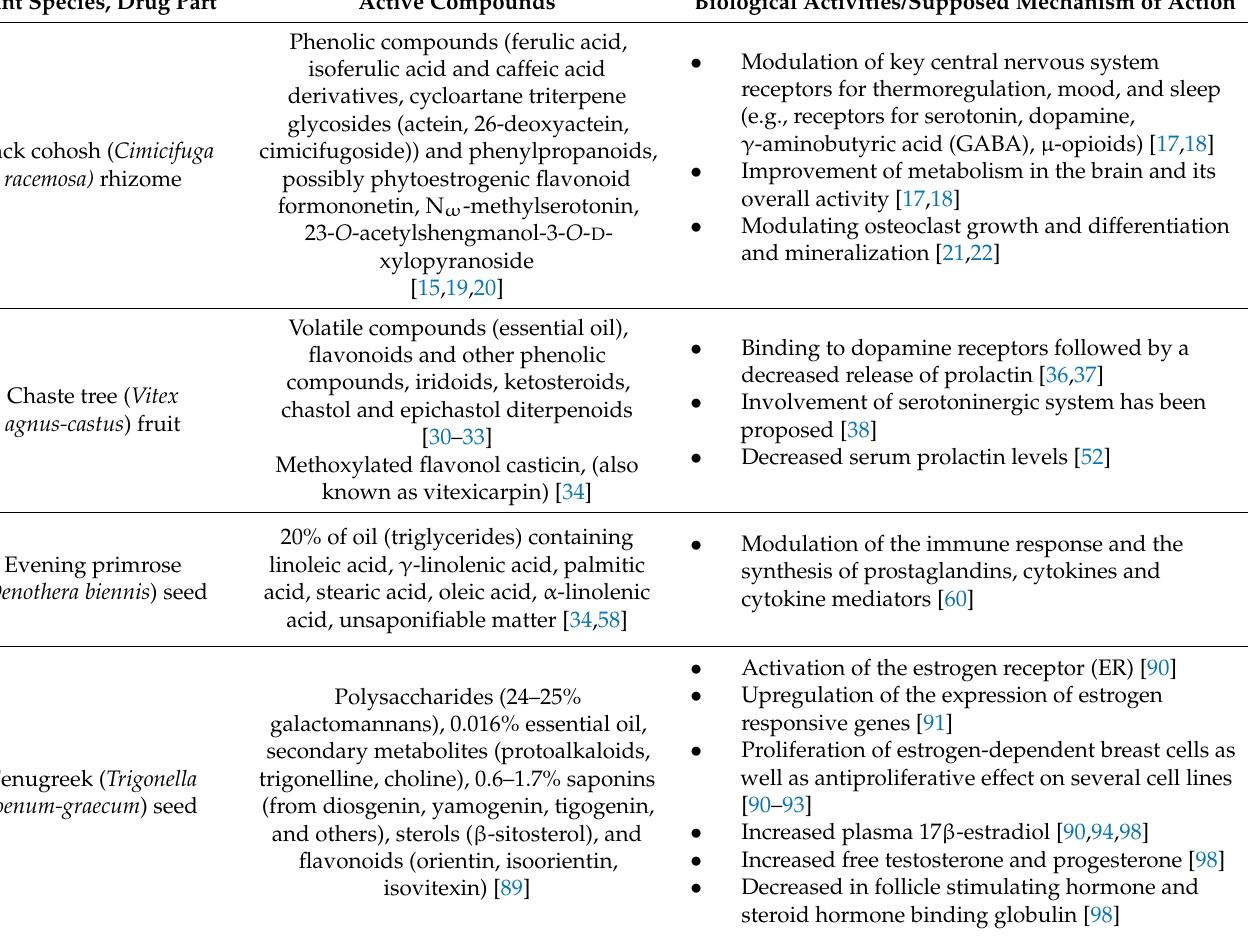
Table 1. Commonly used plants in relieving menopausal